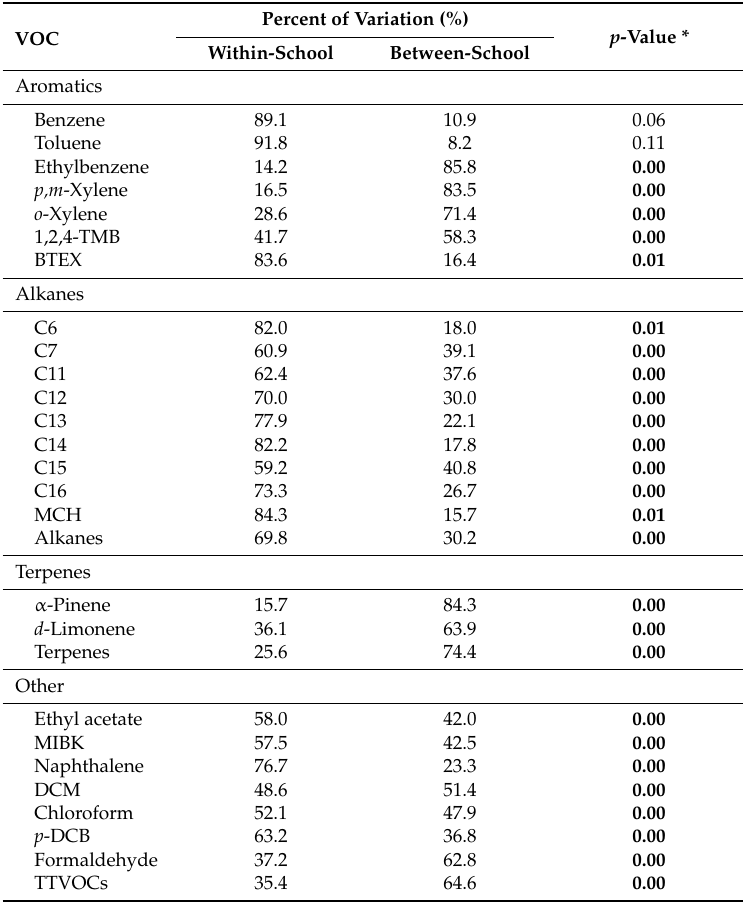
Percent of Variation (%)